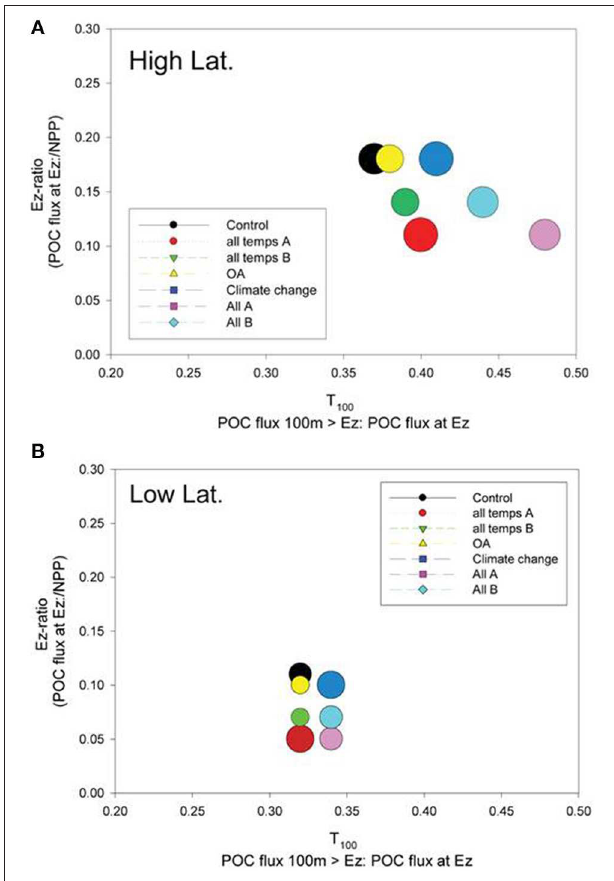
FIGURE 8 | A bubble plot of the Ez ratio vs. T 100 (both defined in the plot labels) for the (A) high latitude and (B) low latitude cases. The model simulation represented by each bubble is color-coded as for Figures 6 , 7 . The diameter of the bubble is scaled to column-integrated NPP used in the model